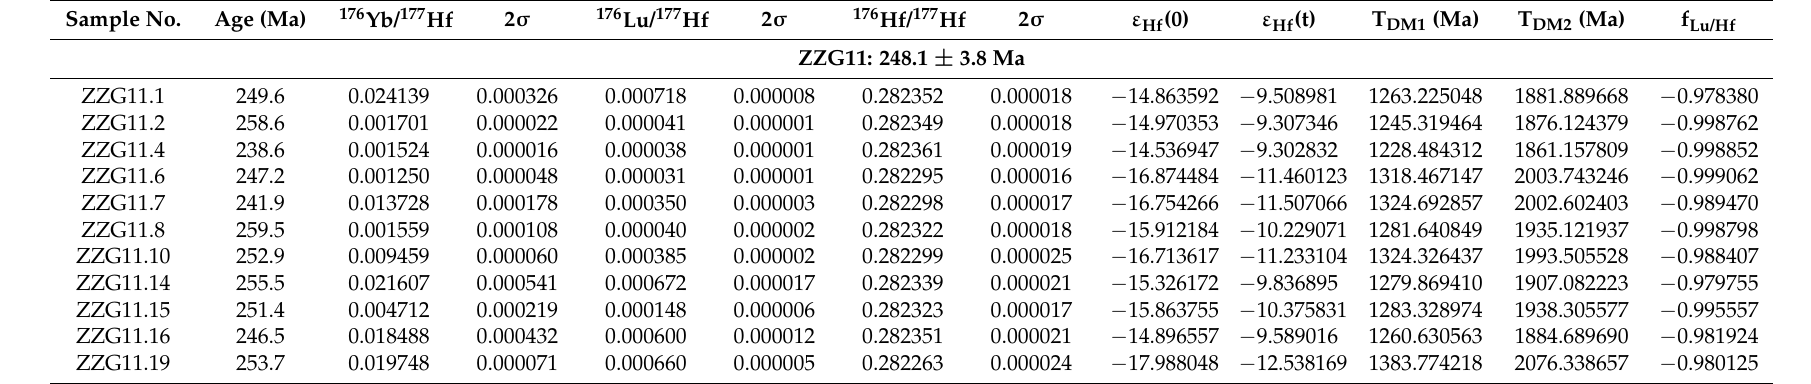
Table 3. Zircon Lu-Hf isotopic composition of the porphyritic dacite samples ZZG11 and